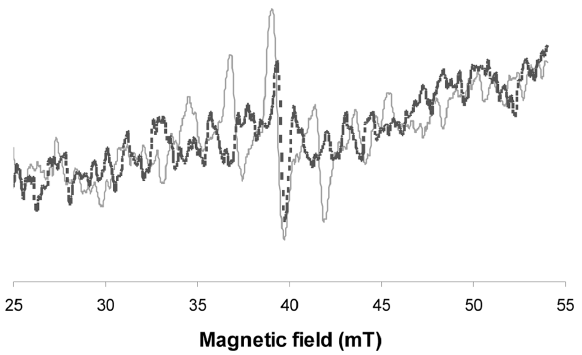
Figure 3. (dotted line) L-band EPR spectrum of an unrestored irradiated tooth (10Gy) and (plain line) restored and irradiated tooth (10Gy).